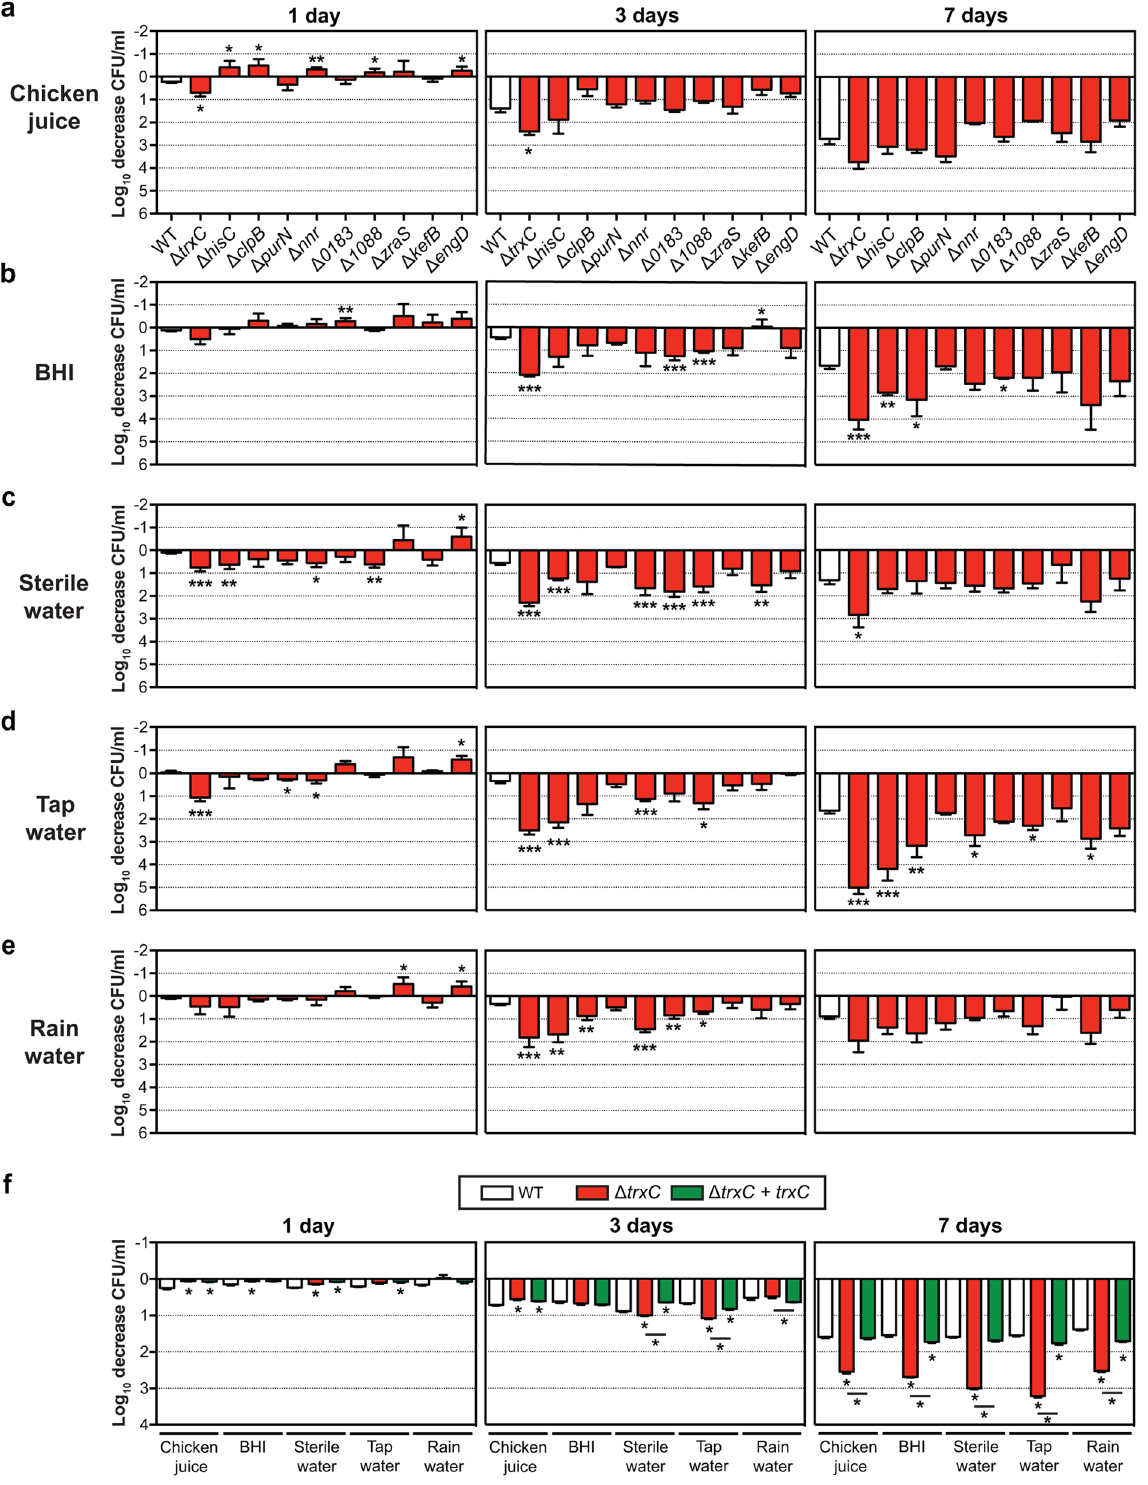
Figure 5. Validation of Tn mutant library screen during survival at low temperature under nutrient-rich and –poor conditions. ( a–e ) Survival of defined C . jejuni M1cam gene deletion mutant in ( a ) BHI, ( b ) chicken juice, ( c ) sterile water, ( d ) tap water, ( e ) rain water. Survival of trxC defined gene deletion mutant and complemented mutant ( F ), at 4 °C in different media. Data shown are Log 10 decrease of CFU/ml relative to the 0 day time-point and plotted as means with SEM ( n ≥ 4). Statistical significance was analysed using a Mann-Whitney test with * P < 0.05, ** P < 0.01 and *** P <